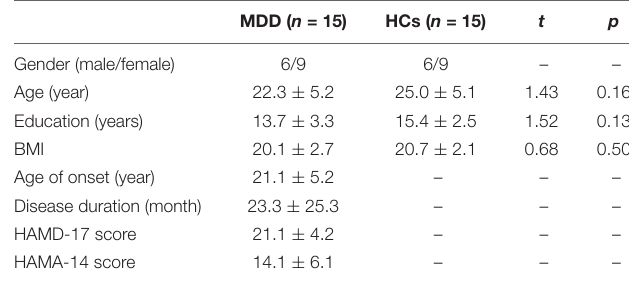
TABLE 1 | Clinical characteristics of patients with MDD and HCs.